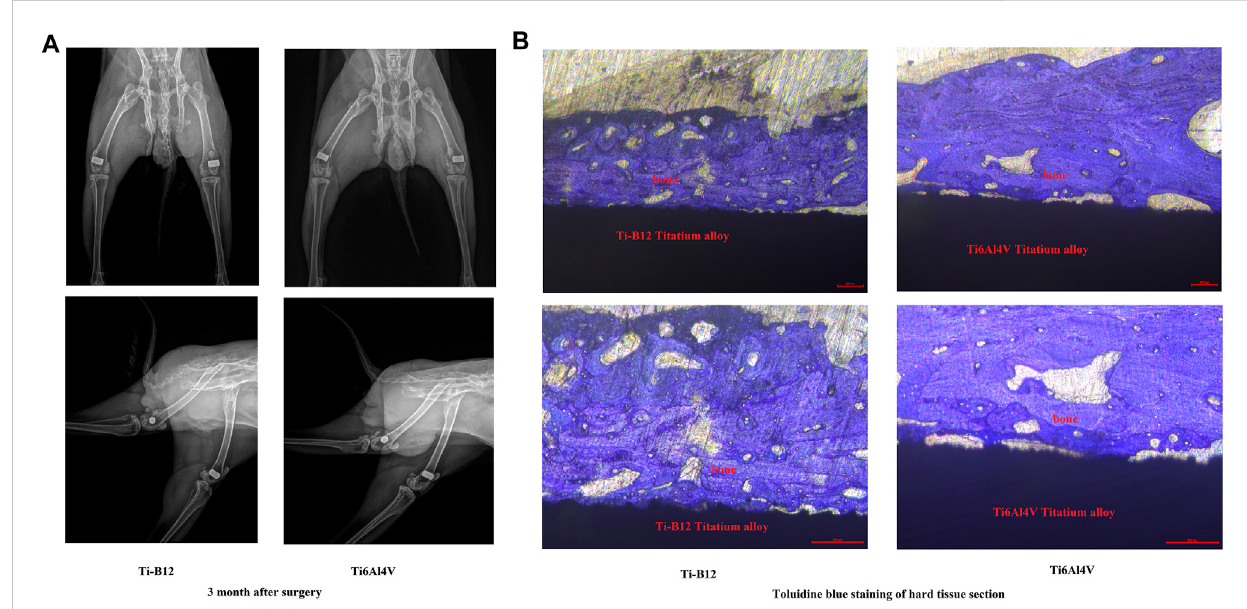
FIGURE 10 In vivo experiments on animals. (A) results of the X-ray examination 3 months after the operation; (B) results of the toluidine blue staining of hard tissue